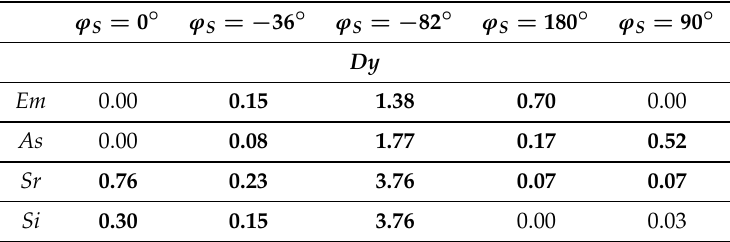
Figure 9. Median value and 95% confidence interval of direction ratings per beam direction ϕ S . Please note the varying y -axis as per sub-figure a range of [ 15 ◦ , − 25 ◦ ] around the median of the Dy ratings is shown. Table 1. p -values (Wilcoxon signed-rank test with Bonferroni–Holm correction) for ratings of direction. Insignificant differences ( p -values ≥ 0.05) are indicated by bold